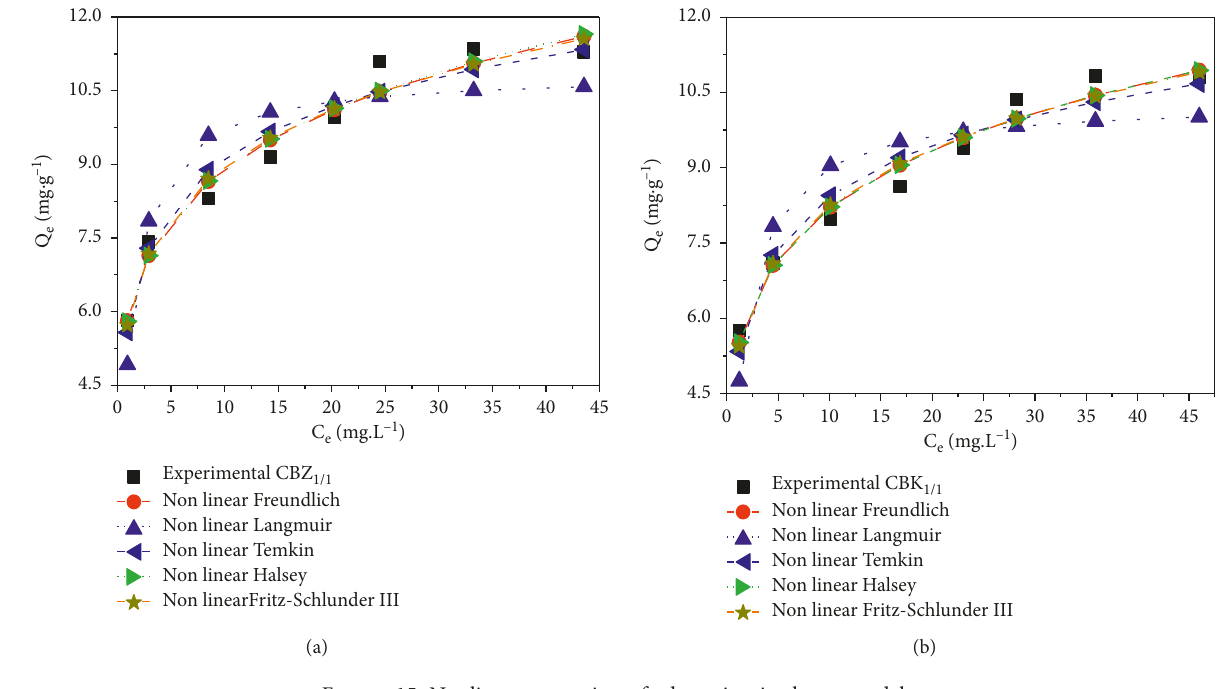
Figure 15: Nonlinear regression of adsorption isotherm models.